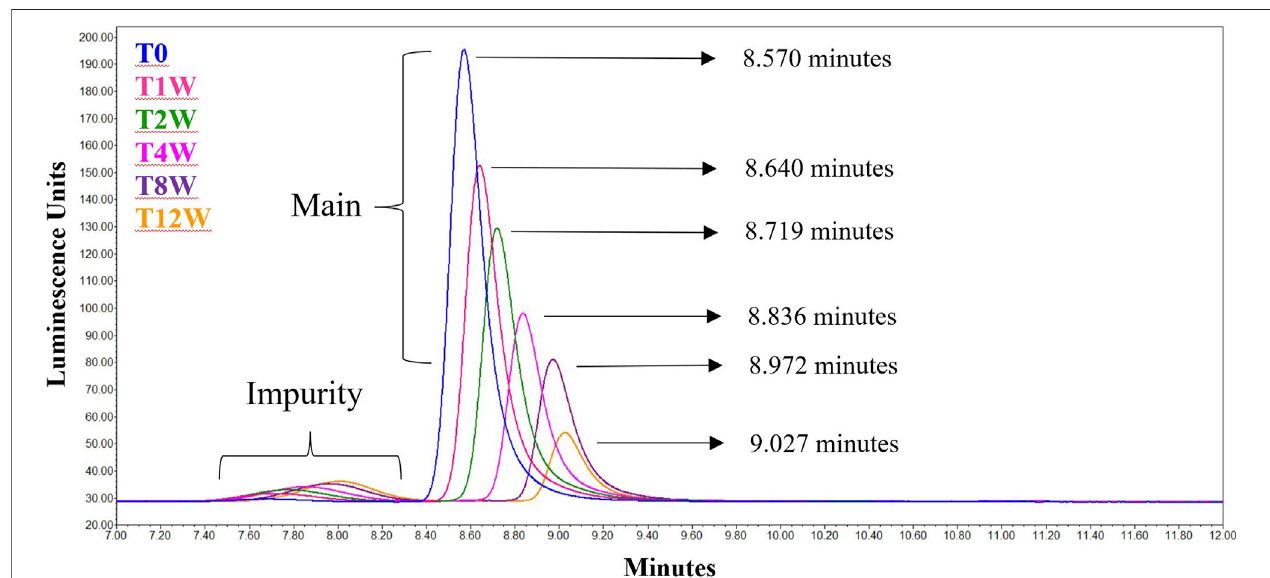
FIGURE 1 | Singlicate AEX-HPLC data from the AdC68 #1 accelerated stability time course. Peaks designated the “ Main ” and “ Impurity ” are labeled as such. The timepoints in the accelerated stability study are labeled on the fi gure, with blue representingthe pro fi le ofthe unstressed material.The retention times for each time point are shown in the fi